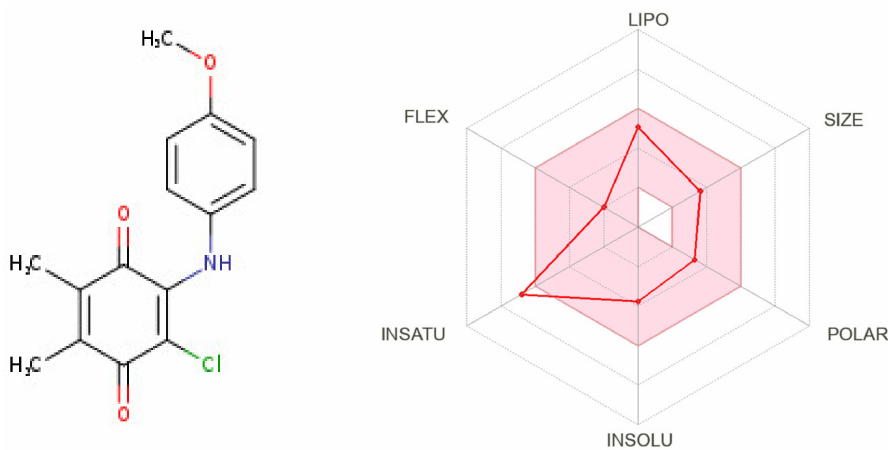
Figure 9. Radar diagrammatic representation of physicochemical properties of ABQ-3 from Swis- sADME (Swiss Institute of Bioinformatics, Lausanne, Switzerland).